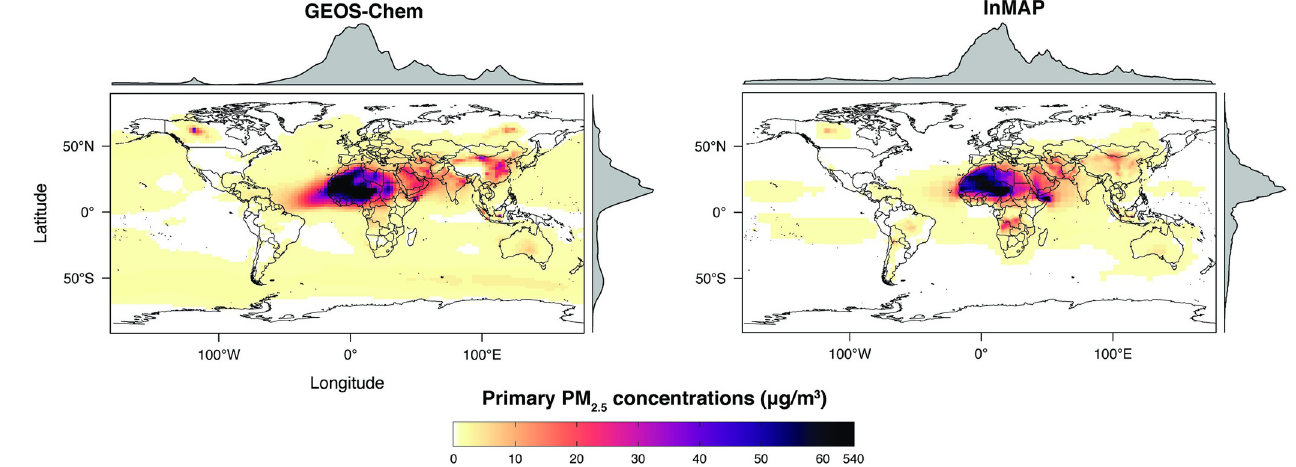
Fig 10. Global InMAP and GEOS-Chem annual-average ground-level primary PM 2.5 concentrations.